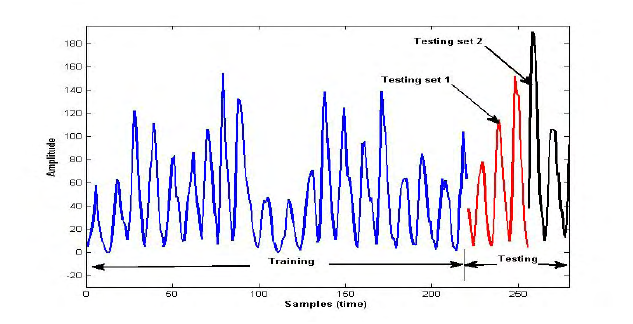
Fig. 4. Sunspot time